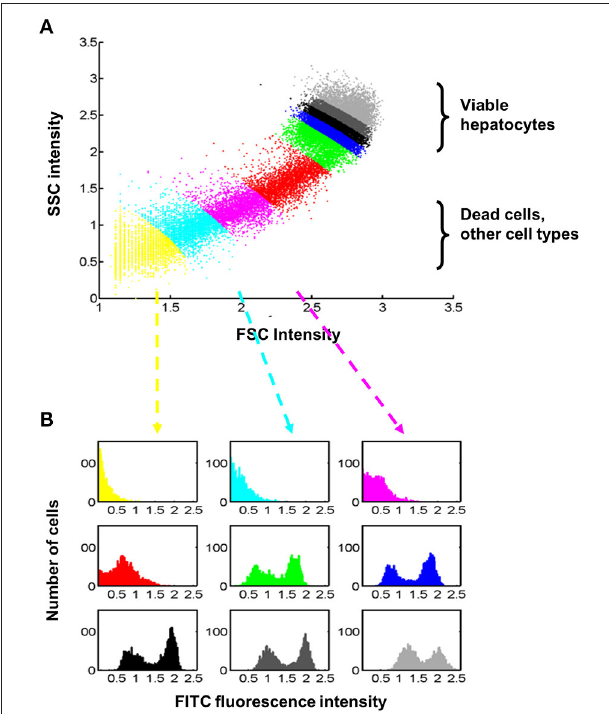
FIGURE 5 | Relationship between selections of cells based on forward- and side-scatter intensities and the respective fluorescence intensity for insulin-FITC. (A) Dead cells, primarily originate from collagenase tissue digestion, and other cell types cannot be clearly separated from hepatocytes automatically. For illustration purpose, 9 different groups were defined containing the same number of cells but at different distances from the origin (FSC = 0, SSC = 0). We applied rather stringent thresholds for selection of viable hepatocytes and analyzed on average around 30.8% of cells. (B) The fluorescence intensity in the insulin-FITC channel is dependent on the selected forward- (FSC) and side-scatter (SSC) signals, which demand a statistically valid analysis which is robust against the definition of thresholds. The color of the histograms indicates the group defined in (A) . All viable hepatocytes (green, blue, black, and gray) show a bimodal distribution with regard to fluorescence (FITC).